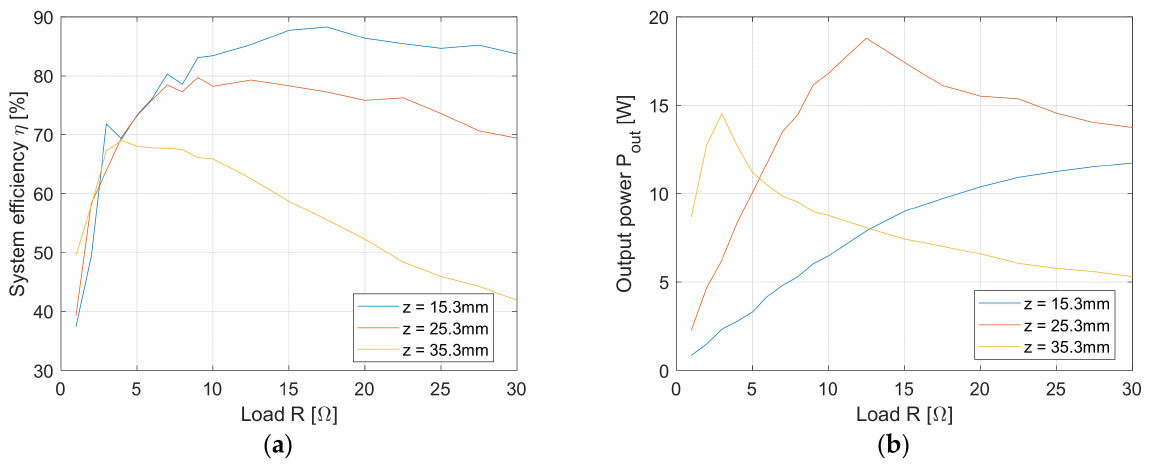
Figure 22. Impact of load variation on the IPT with the single DD coil structure: ( a ) efficiency of the system; ( b ) output power